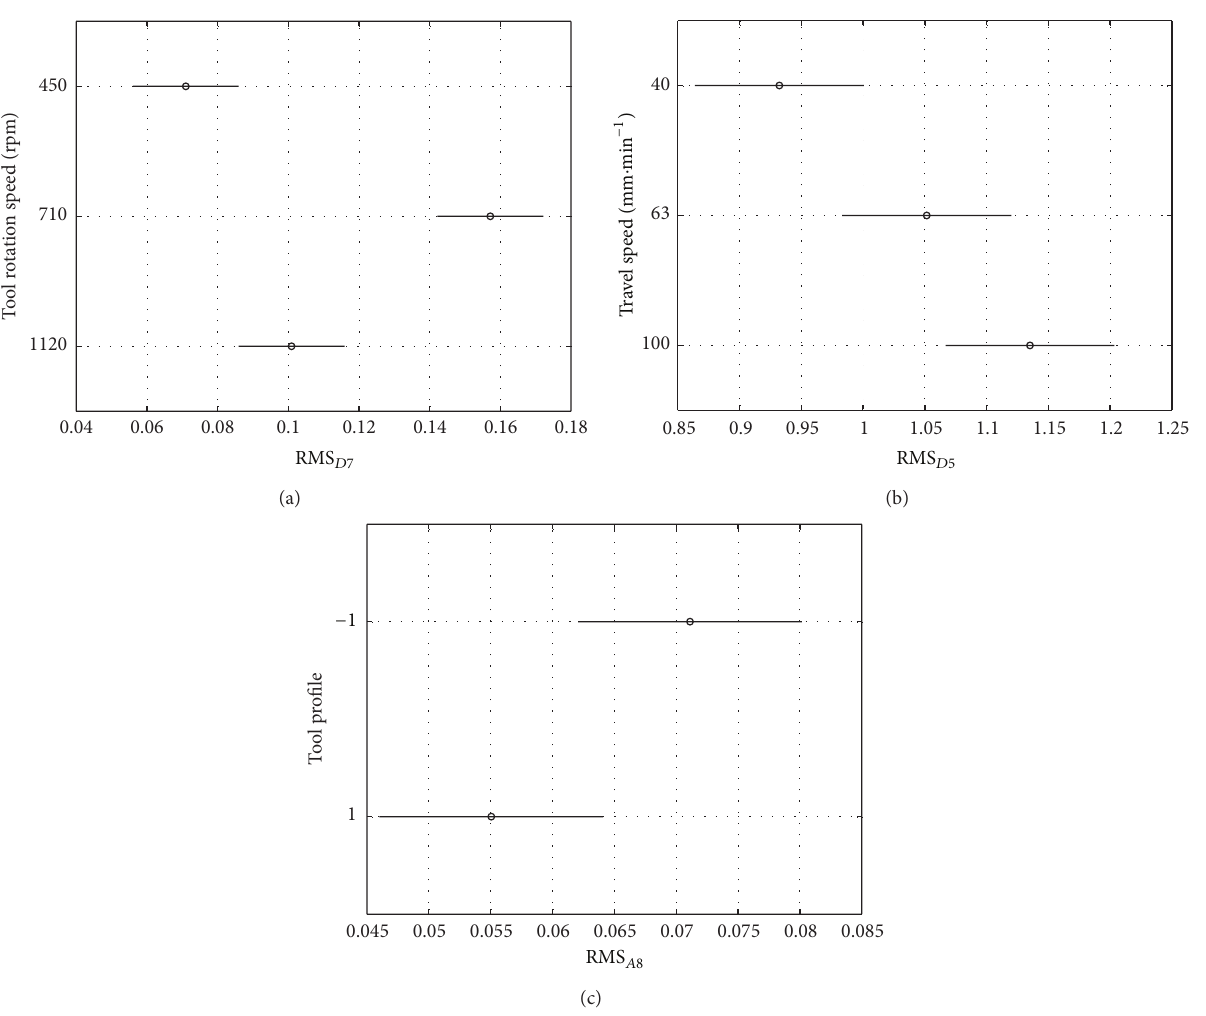
Figure 6: Influence of the FSW parameters on DWT decomposed signal. (a) Tool rotation speed, (b) travel speed, and (c) tool profile.